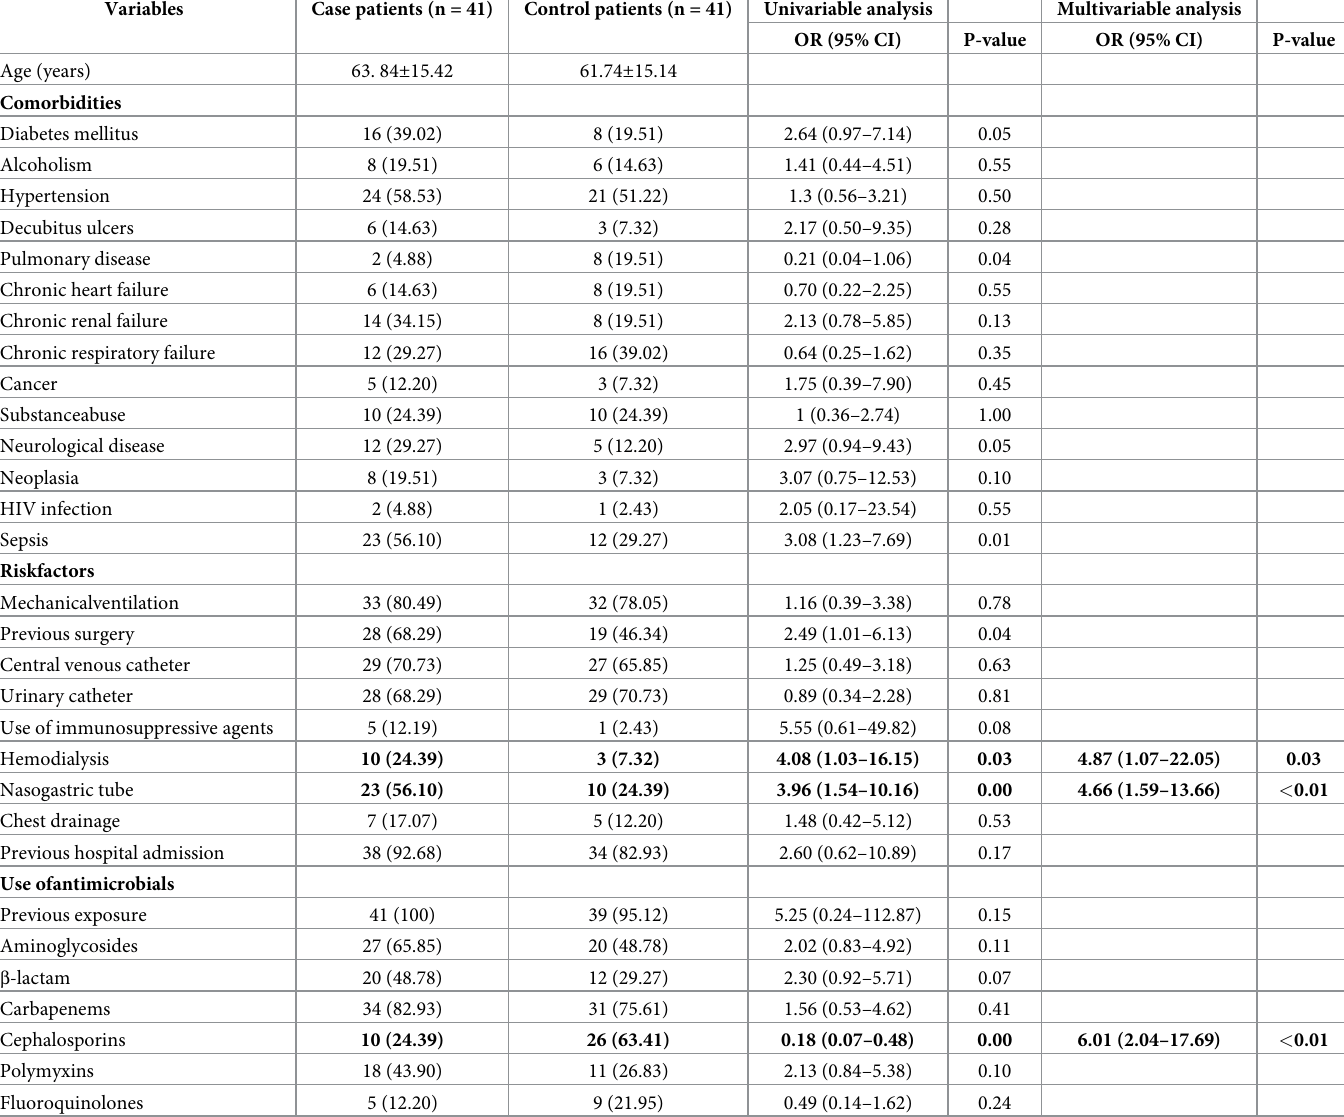
Table 1. Summary of risk factors associated with OXA-23-producing A . baumannii